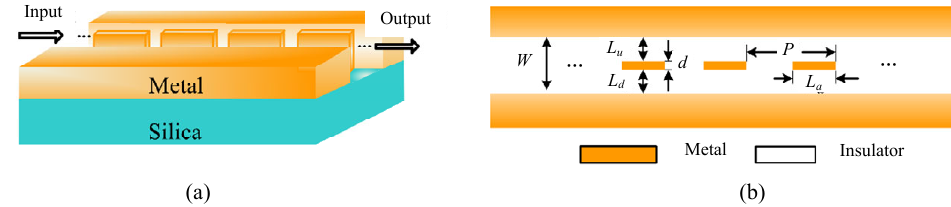
Fig. 1 Schematic diagram of the plasmonic MIM structure: (a) three-dimensional view and (b) corresponding two-dimensional view.